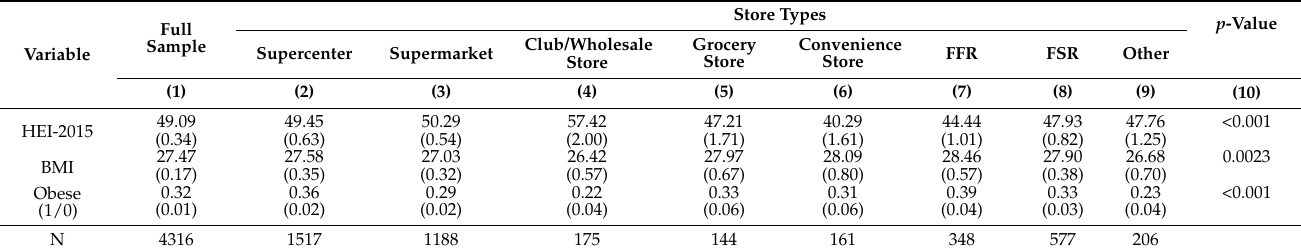
Table 1. Summary statistics of outcome variables by store choices in the